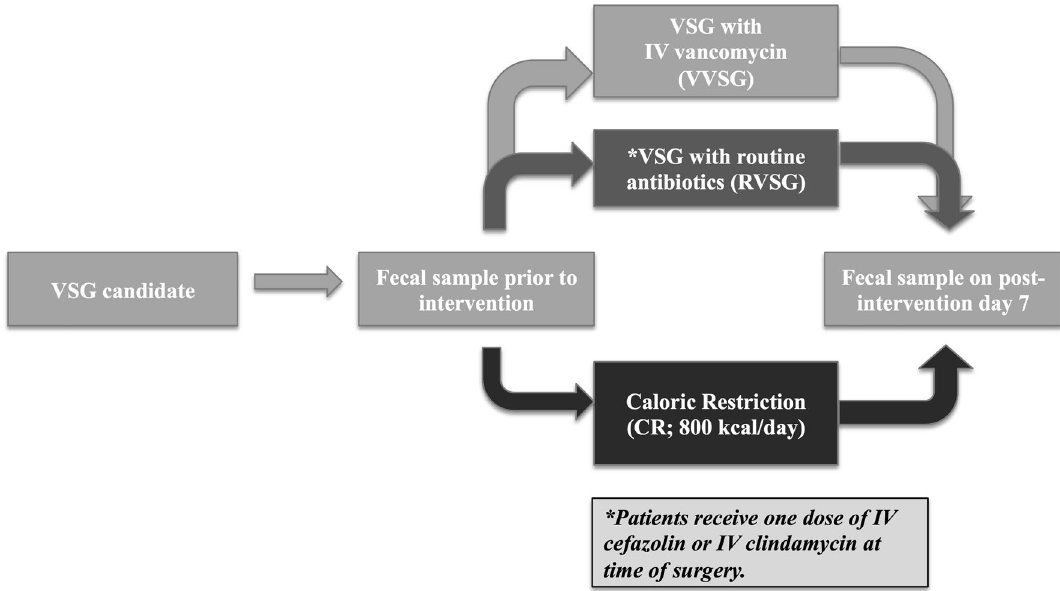
Figure 4. Study design. The objective of the study was to evaluate the relative contributions of important peri- operative factors in shaping the gut microbiome acutely following VSG in order to identify changes that may contribute to the metabolic efficacy of the procedure. 32 patients were recruited to undergo VSG with routine intravenous antibiotics (RVSG; n = 12), VSG with intravenous vancomycin as peri-operative antibiotic (VVSG; n = 12), or caloric restriction (CR; n = 8) which is routinely implemented in post-surgical cares. Intravenous vancomycin was specifically chosen due to its poor intestinal penetrance thus allowing for the evaluation of the impact of the single dose of peri-operative antibiotic on the composition of the